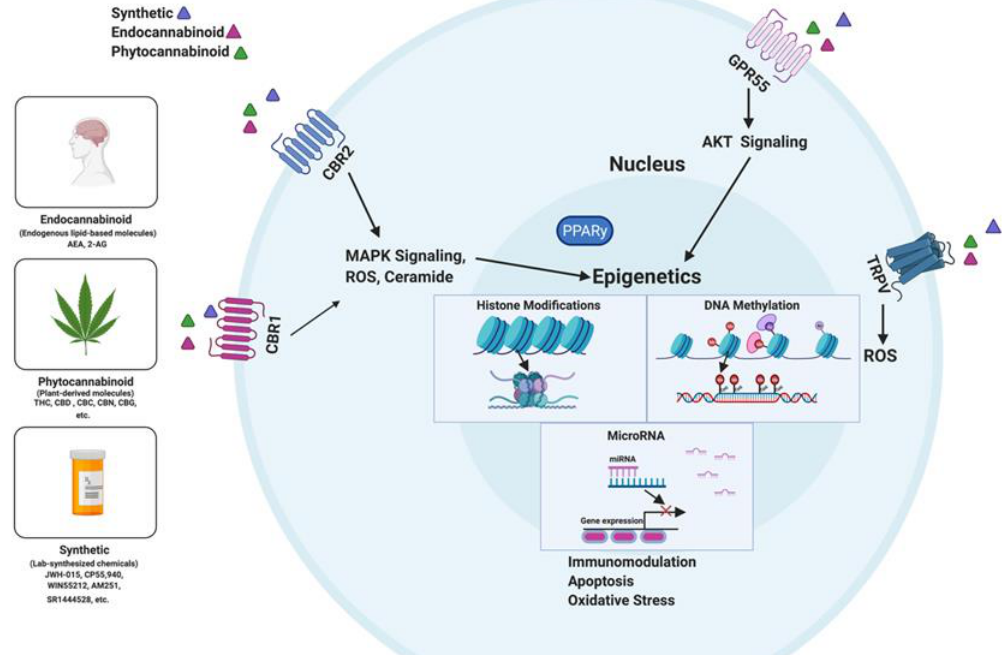
Figure 1. An overview of cannabinoid-induced epigenetic alterations through DNA methylation, histone modifications, and miRNA dysregulation. Several classes of cannabinoids, which include synthetic cannabinoids, endocannabinoids, and phytocannabinoids, regulate inflammation by binding to several receptors (CB1 and CB2, GPR55, and TRPV) found on immune cells. Activation of the CB1 and 2 leads to MAPK signaling transduction and increases the production of ROS and ceramide. The MAPK pathway induces epigenomic changes. On the other hand, GPR55 activation leads to AKT signaling transduction, which stimulates epigenetic alterations.